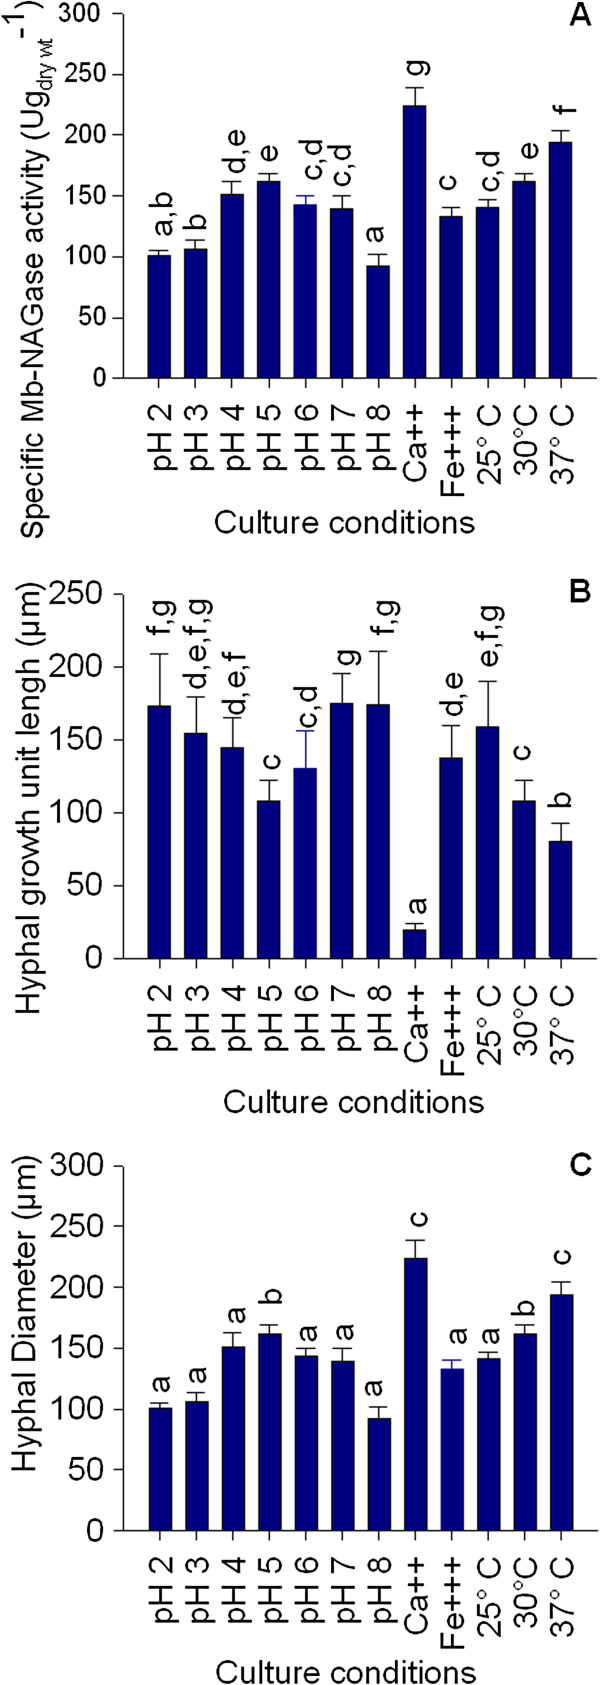
Effect of culture conditions on specific Mb-NAGase activity (A), hyphal growth unit length (B) and hyphal diameter (C) from A. niger MYA 135. Error bars represent the standard deviation calculated from at least three independent experiments. Bars with the same letter are not significantly different.